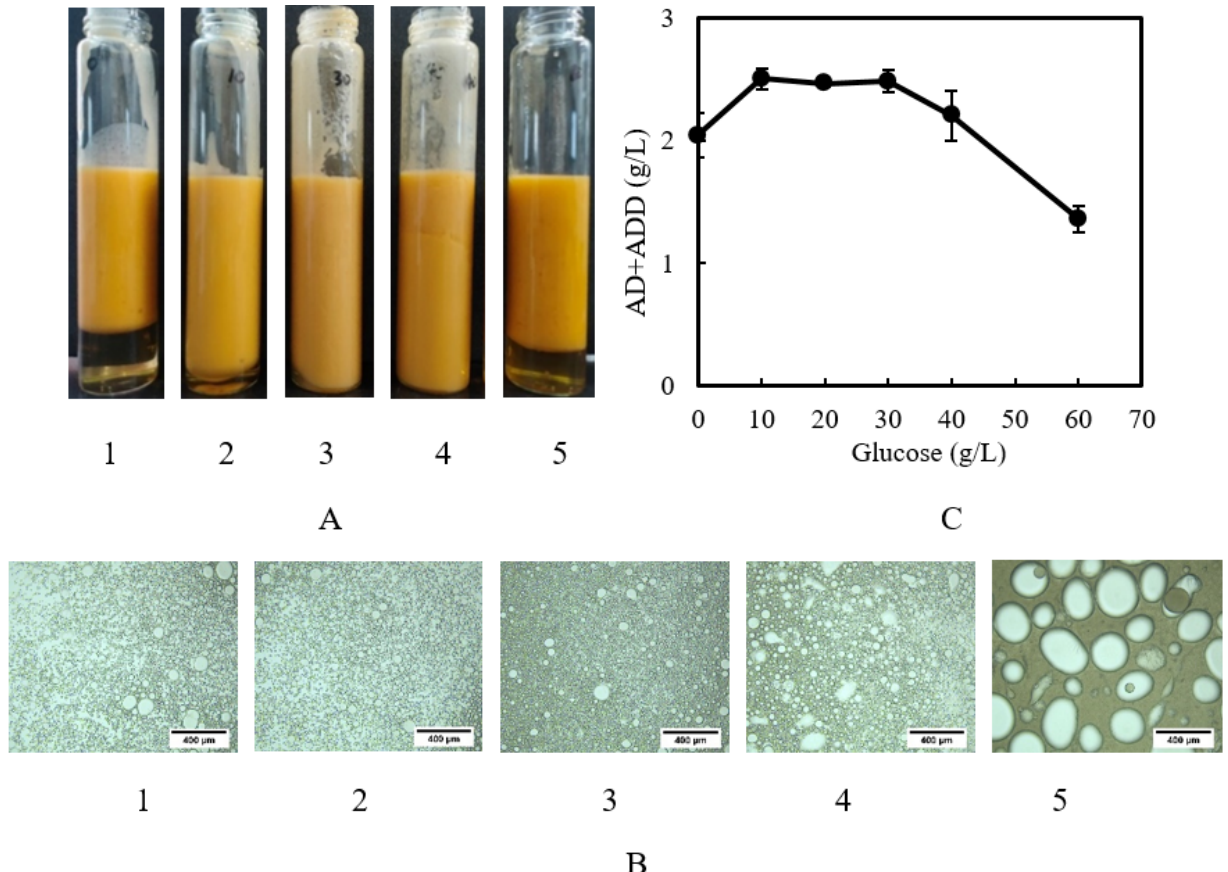
Figure 3. Influence of glucose acting as a co-substrate: ( A ) Emulsion fraction. ( B ) Microscopic emulsions (bar = 400 µ m). ( C ) AD and ADD concentration. In the basic experimental condition, the volume ratio of soybean oil to the aqueous culture medium was 15:35 mL. The concentration of phytosterols in the soybean oil was 25 g/L. The microbial transformation time was 7 days. No. 1, 2, 3, 4, and 5 corresponded to glucose concentrations in the aqueous culture medium of 0, 10, 30, 40, and 60 g/L, respectively.